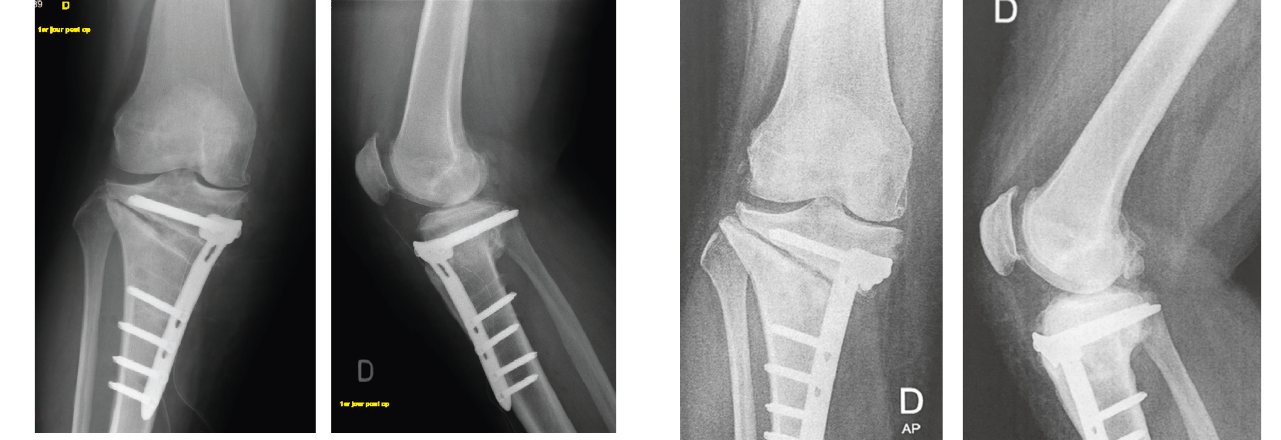
Figure 5: June 2010, postoperative X-rays after revision.